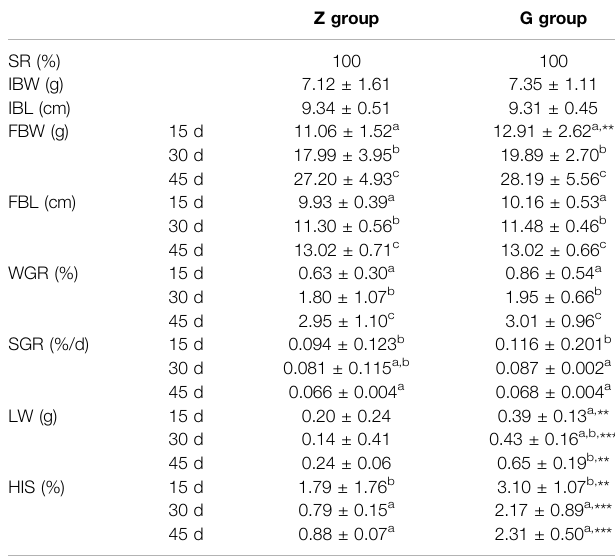
TABLE 3 | Effects of high starch diet on the survival and growth of largemouth